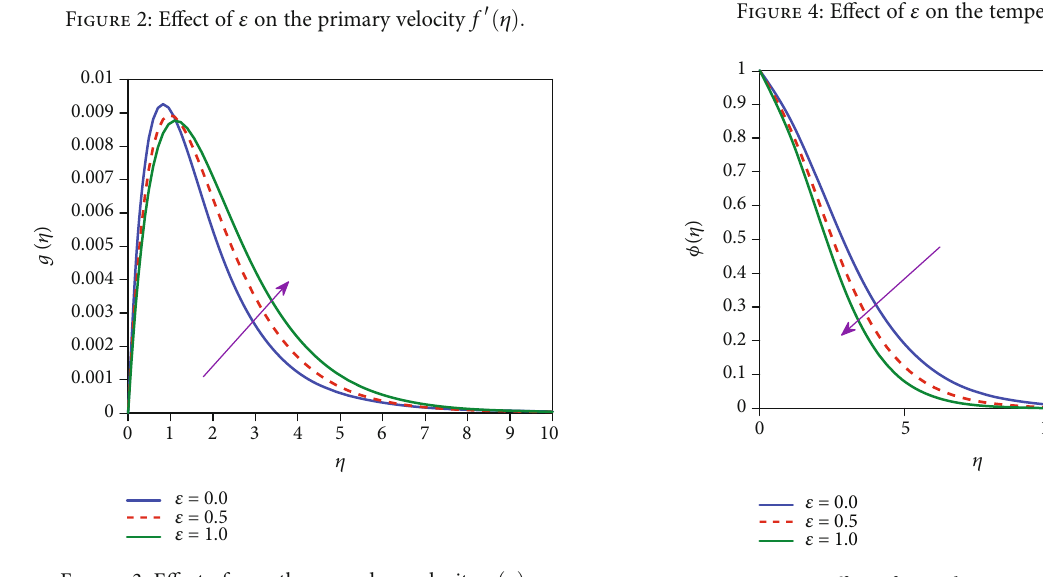
Figure 5: E ff ect of ε on the concentration ϕ ð η Þ . Figure 3: E ff ect of ε on the secondary velocity g ð η Þ .